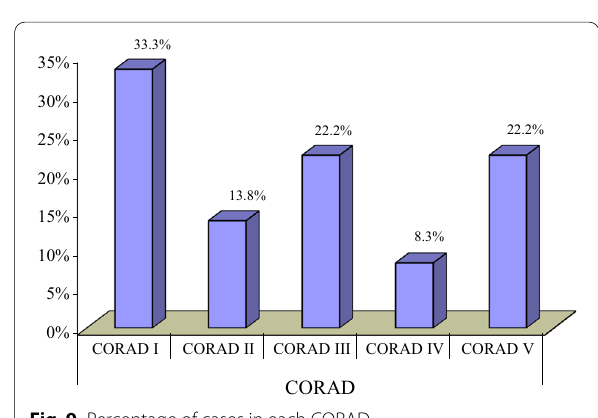
Fig. 9 Percentage of cases in each CORAD